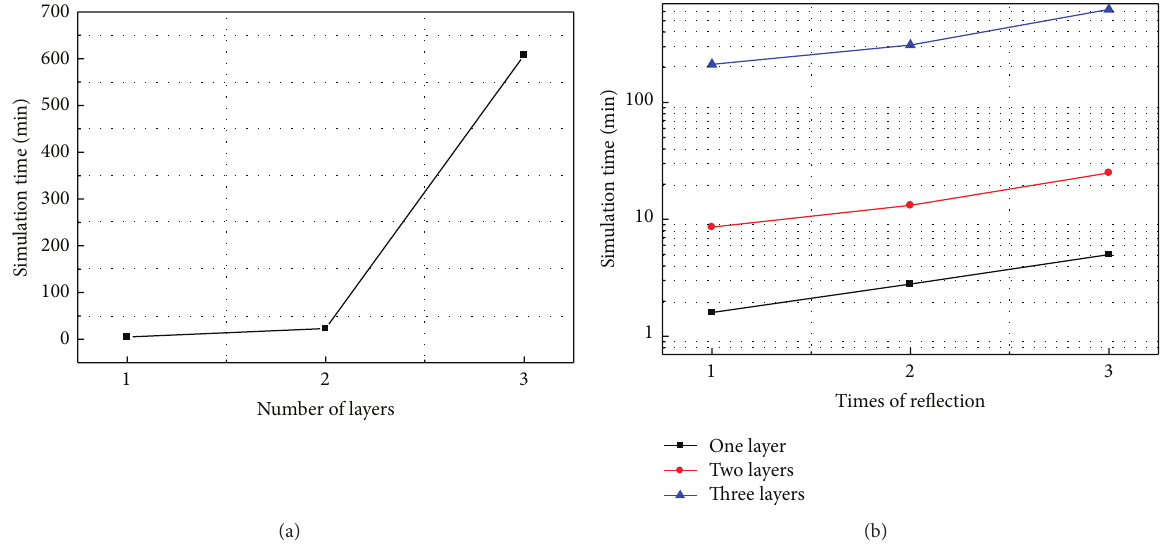
Figure 7: (a) Simulation time with the layers considered in the model. (b) Simulation time with the times of reflection considered in the model.